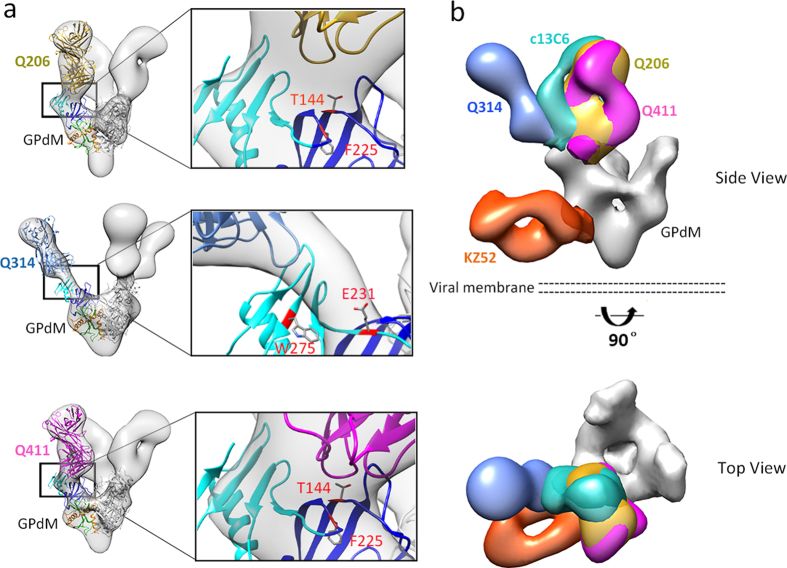
Single-particle EM reconstructions of Q206, Q314 and Q411 Fabs bound to EBOV GPdM.Hybrid models of negative-stain EM reconstructions fit with the EBOV GPdM crystal structures (PDB assessing number 3CSY) and a reference Marburg virus mAb MR78 Fab (PDB assessing number 3X2D). (a) Side view of individual Fab Q206 (mustard), Q314 (blue) and Q411 (magenta) bound to the EBOV GPdM. Overall as well as focused views at the binding interface between Fab and GPdM are shown in ribbon diagram. Four residues (T144, F225, E231 and W275) found to be critical for mAb binding and neutralization through mutagenesis study are highlighted and found to be located in the glycan cap (cyan) and the head regions (dark blue) within the EBOV GPdM. b) Side and top views of combined Fabs of Q206 (mustard), Q314 (blue), and Q411 (magenta) bound to the EBOV GPdM relative to the control Fabs c13C6 (cyan) and KZ52 (orange).